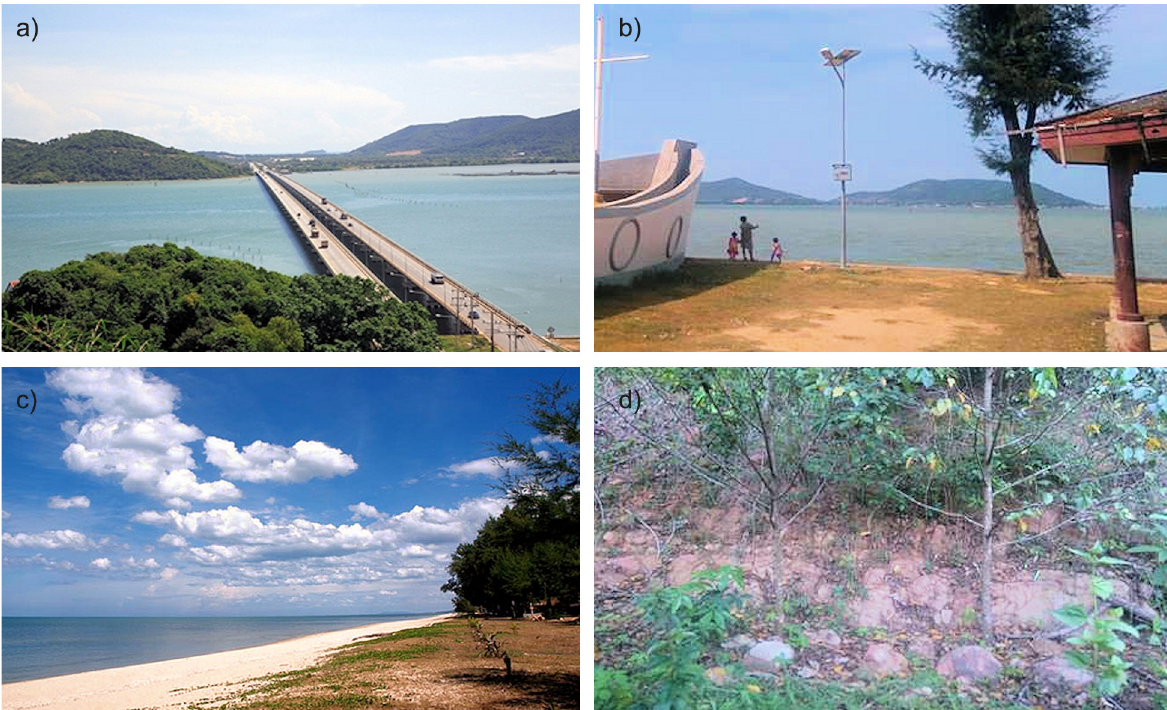
Fig. 4. Songkhla Lagoon